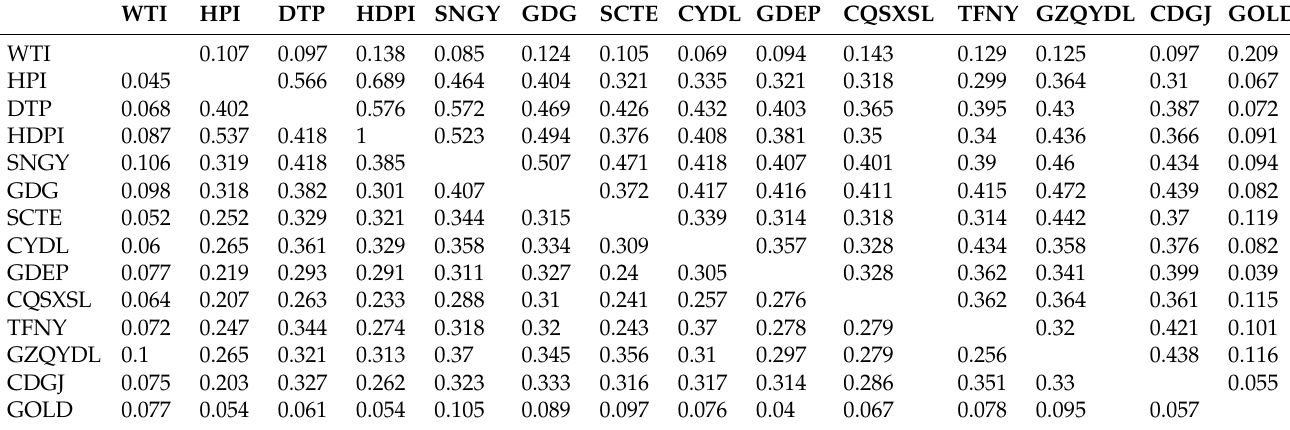
Table 2. Pearson (above diagonal) and Spearman (below diagonal)